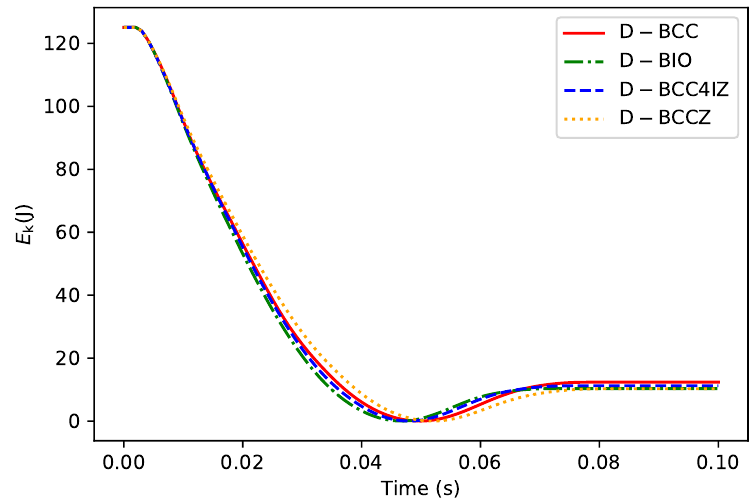
Figure 19. Comparison of E k